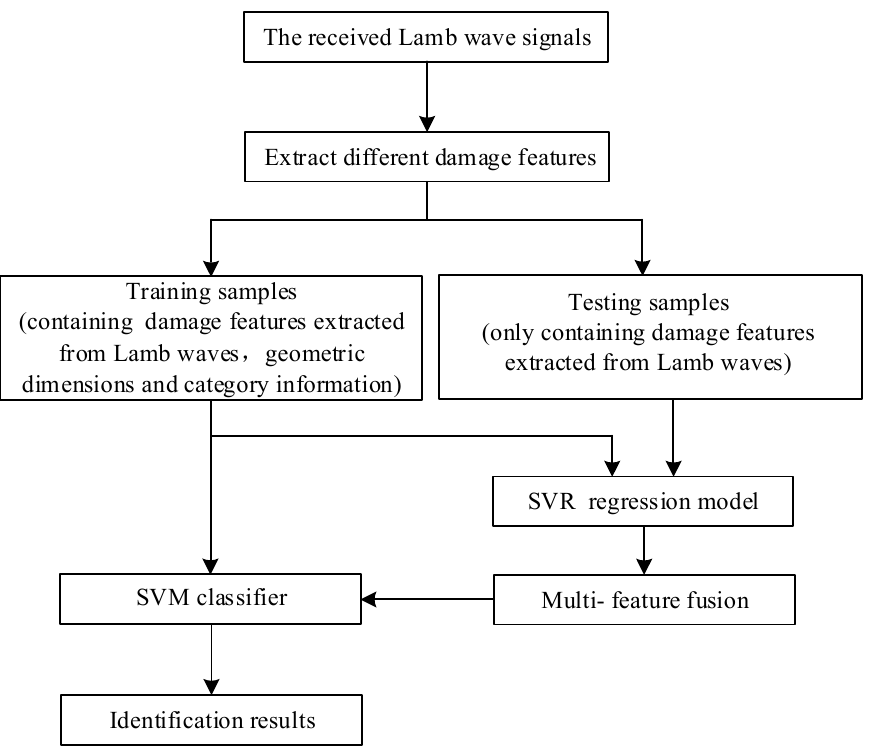
Figure 3. Procedure of stator insulation damage identification based on SVM.